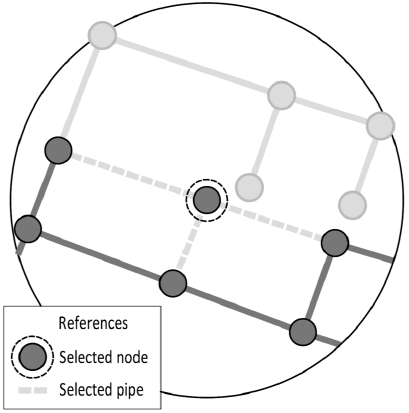
Figure 4. Selected node with many connection pipes to open.